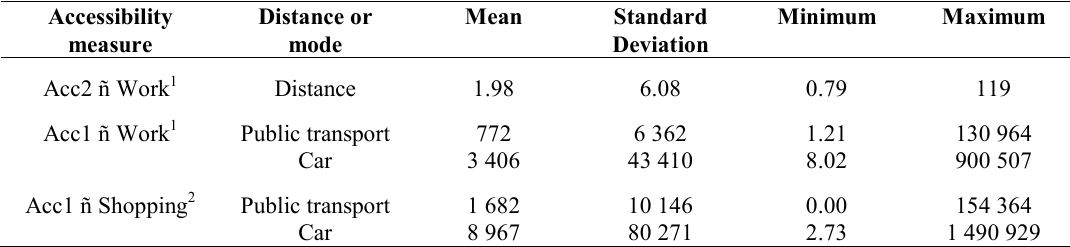
Table 3. The descriptive statistics of the accessibility